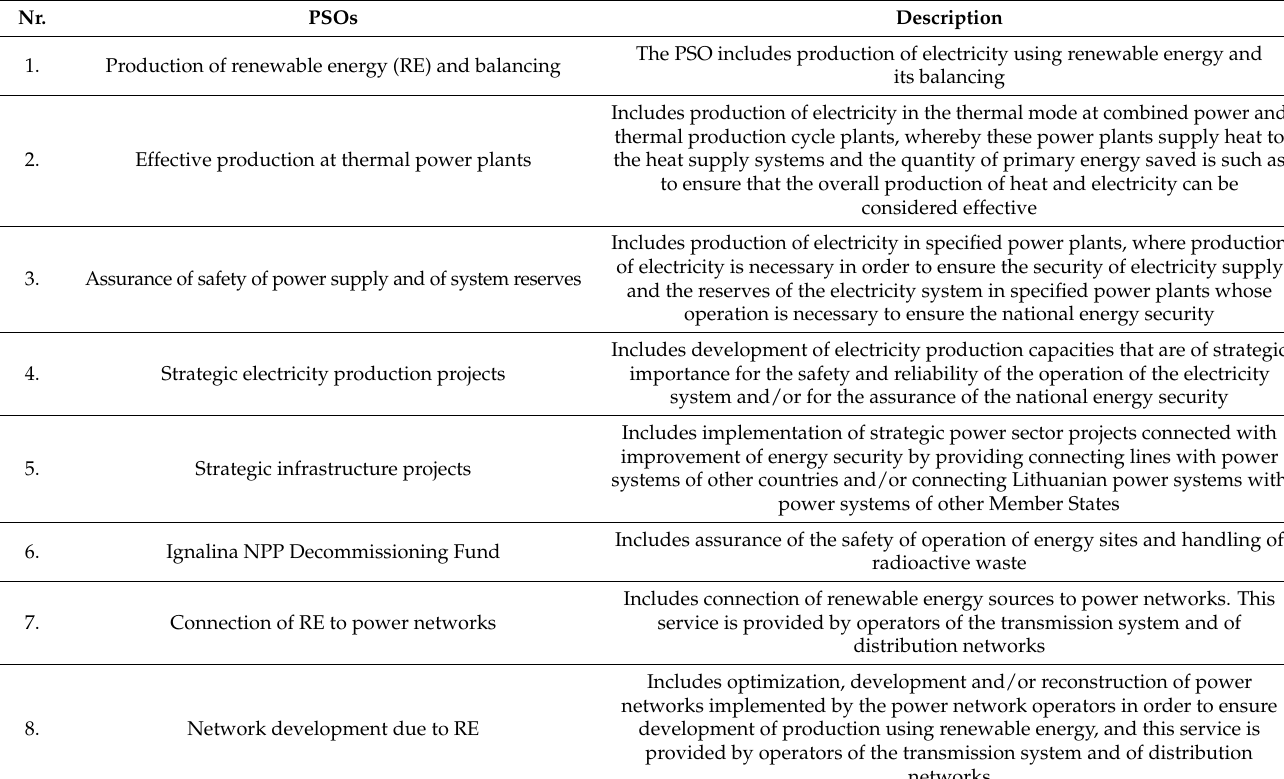
Table 6. Distribution of Lithuanian PSO levy (created by the authors, based on